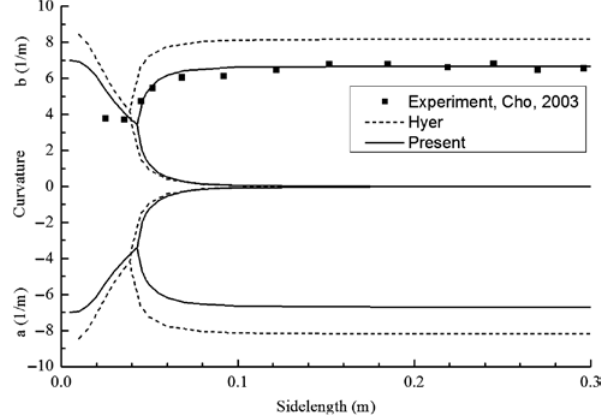
/90 ] laminate 2 2 T